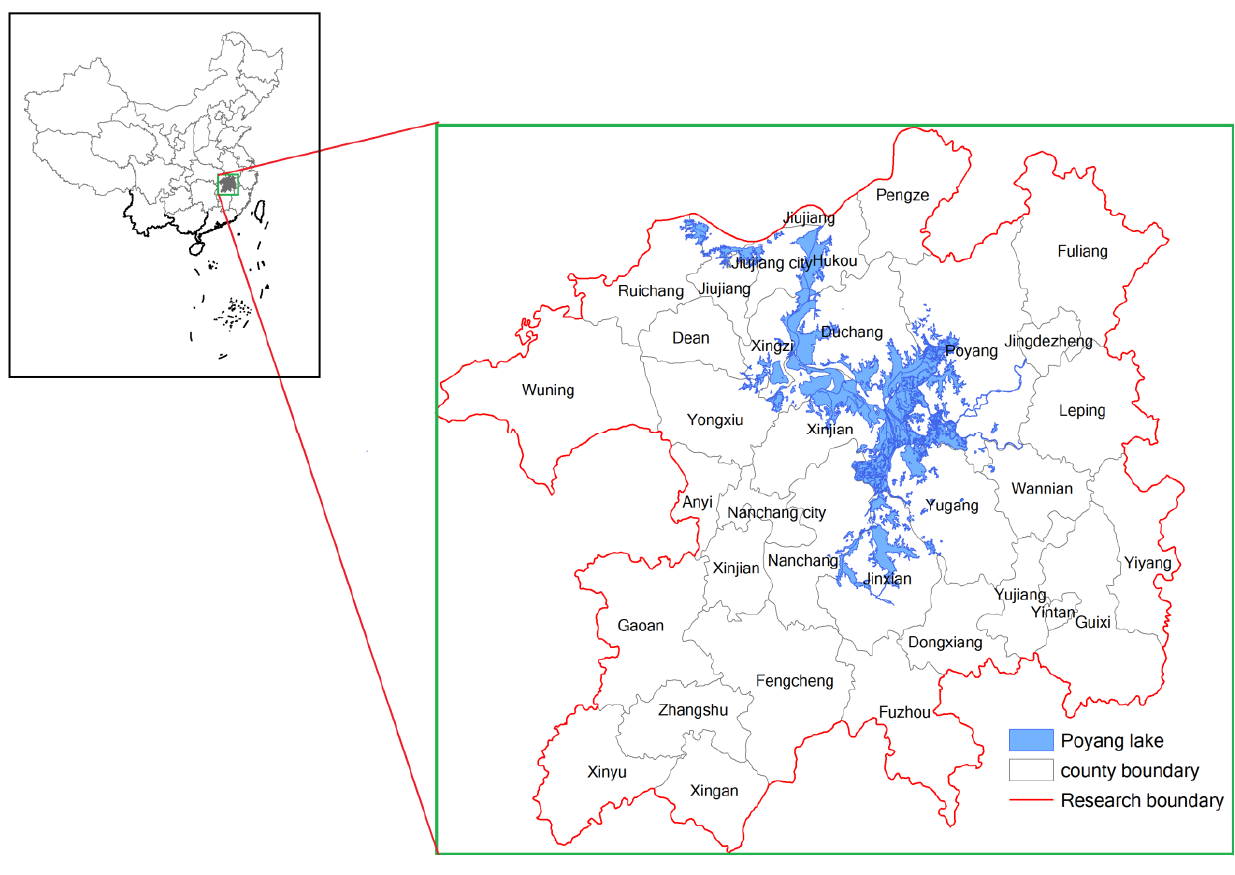
Figure 1. Location map of the Poyang Lake Eco-economic Zone in China.